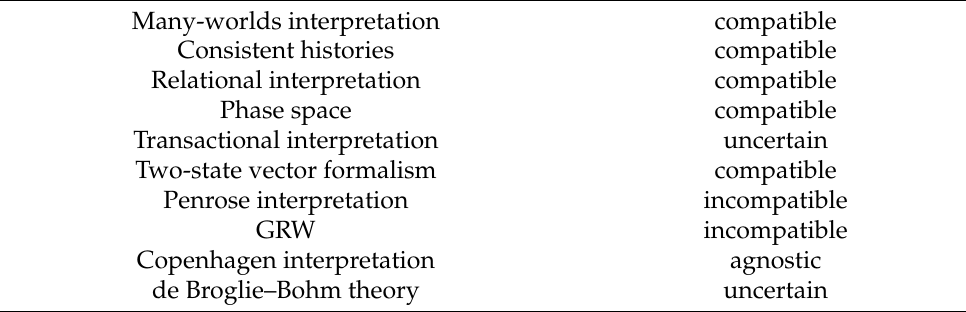
Table A1 for a comparison. Table A1. Compatibility of interpretations of QM with observer-dependent